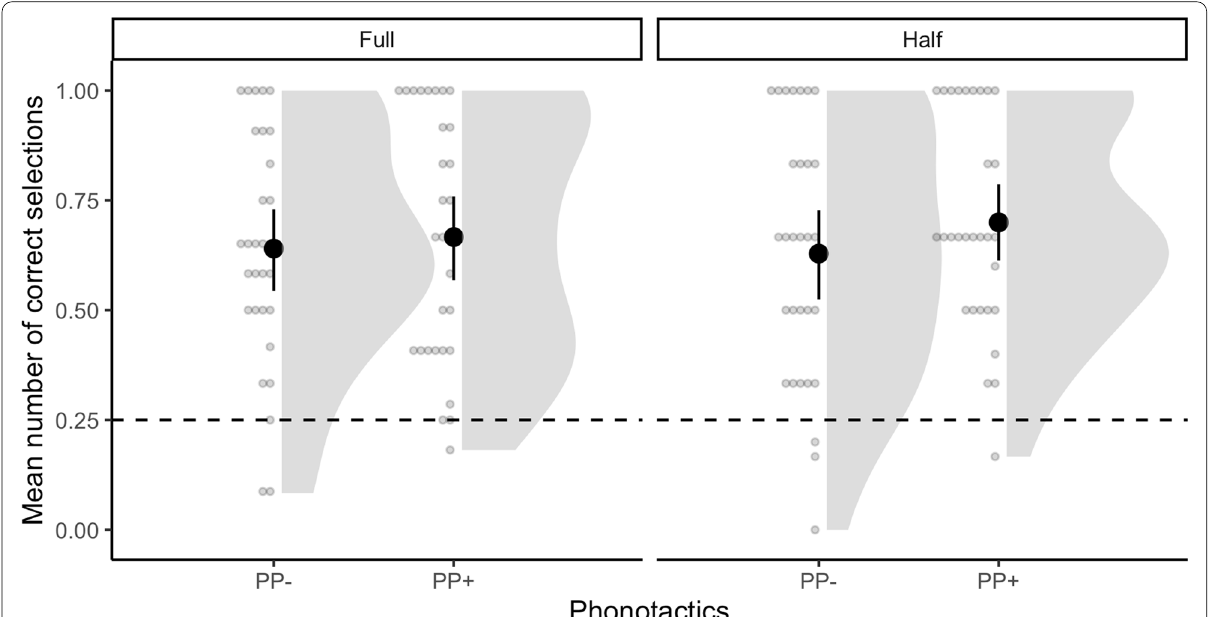
Fig. 2 Mean number of correct selections for PP and PP pairs on experiment 1 using the full dataset (24 trials, full) and half of the dataset (12 − + trials, half). Solid points represent the overall mean; error bars represent 95% CIs (non-parametric bootstrap). Points represent the mean for each participant. The dashed areas depict response distributions. The dashed line represents chance level